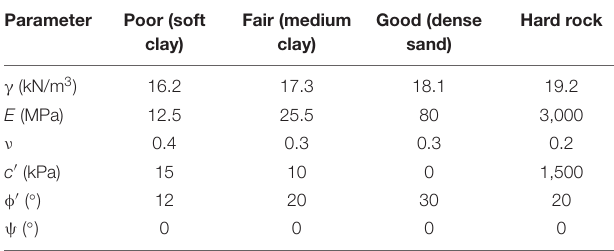
TABLE 2 | Material parameters for different subgrade types.